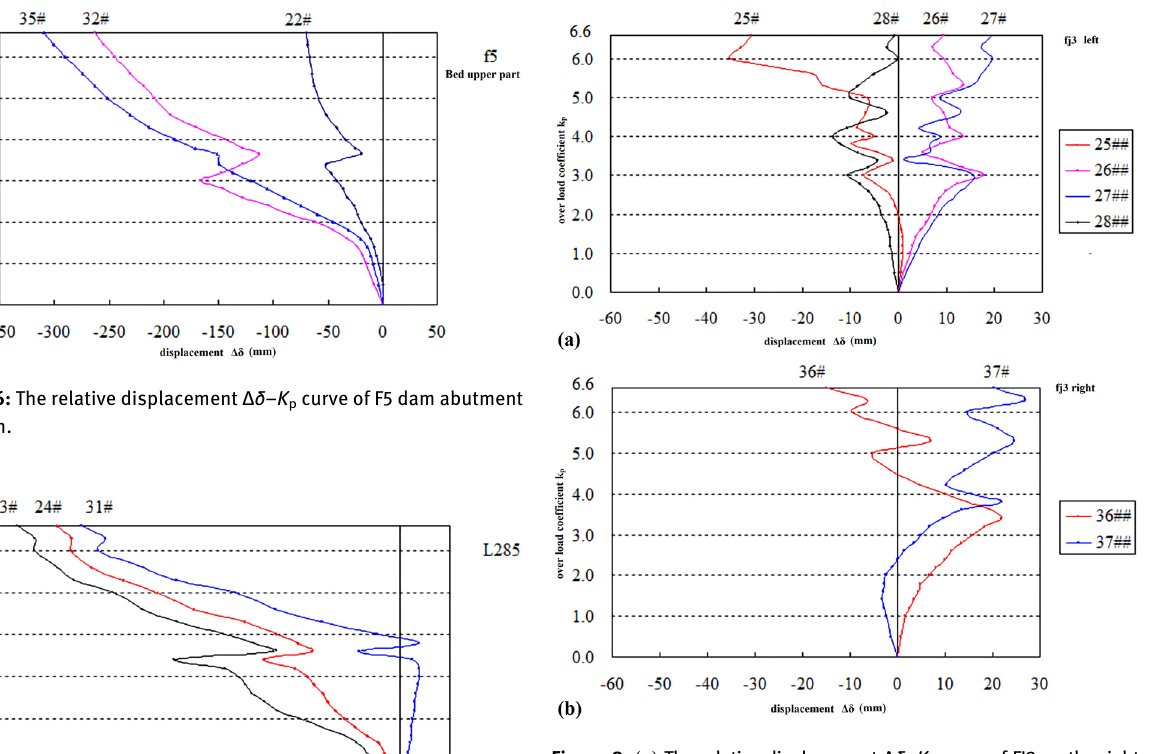
Figure 8: ( a ) The relative displacement Δ δ – K p curve of FJ3 on the right bank. ( b ) The relative displacement Δ δ – K p curve of FJ3 on the left